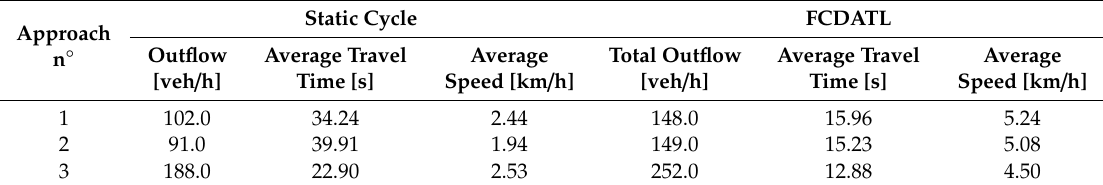
Table 3. Simulation results for maneuver.